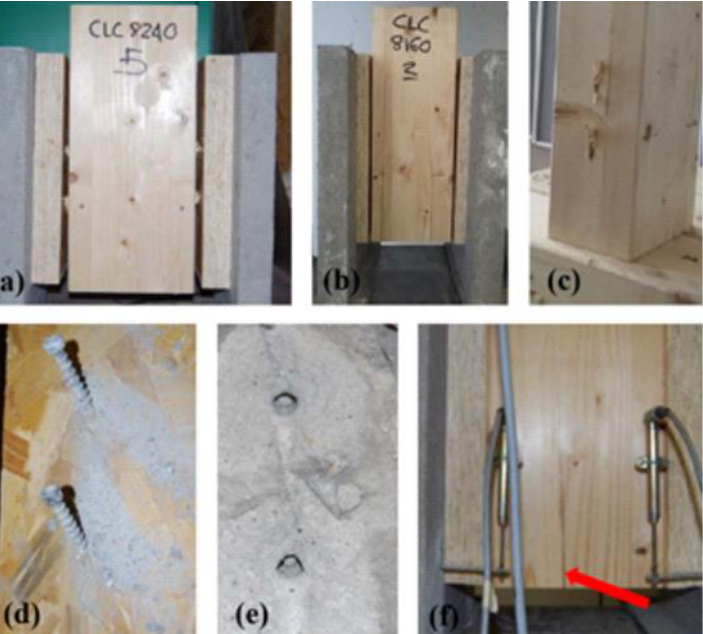
Figure 7. Failure mechanisms for the examined TCC connections in push-out experimental tests: examples of ( a – c ) recurring mechanisms or ( d – f ) infrequent failure modes. Red arrow: failure.